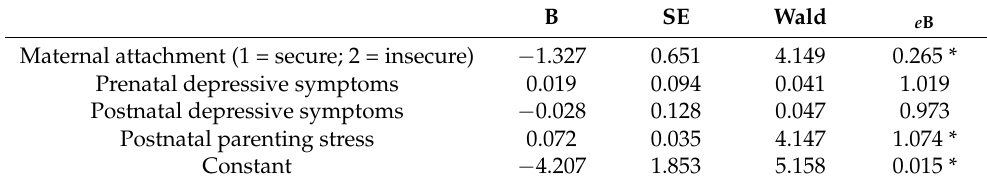
Table 4. Summary of logistic regression analysis predicting child’s attachment at Time 3 (N = 71). B SE Wald e B Maternal attachment (1 = secure; 2 = insecure) − 1.327 Prenatal depressive symptoms 0.019 Postnatal depressive symptoms −